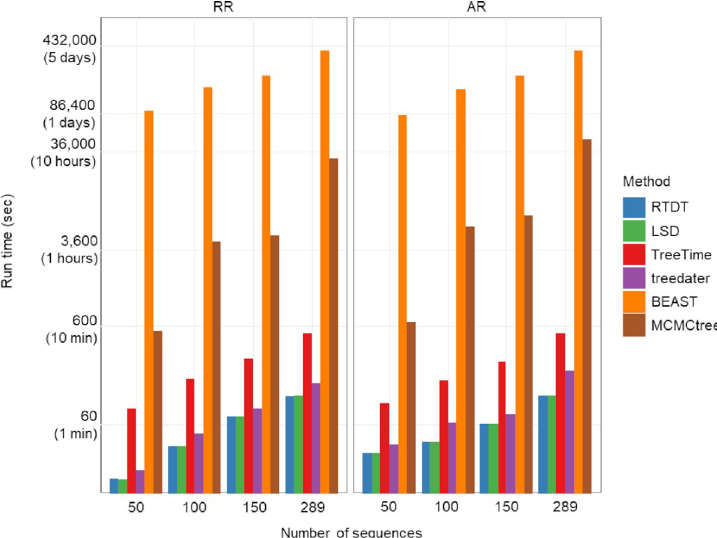
Fig 8. Computational time. We used simulated influenza A datasets (one IBR and one ABR datasets) that contained 289 sequences. From these datasets, we sampled 50, 100, and 150 sequences. For BEAST, we used a log-normal rate model, and correct models were selected for